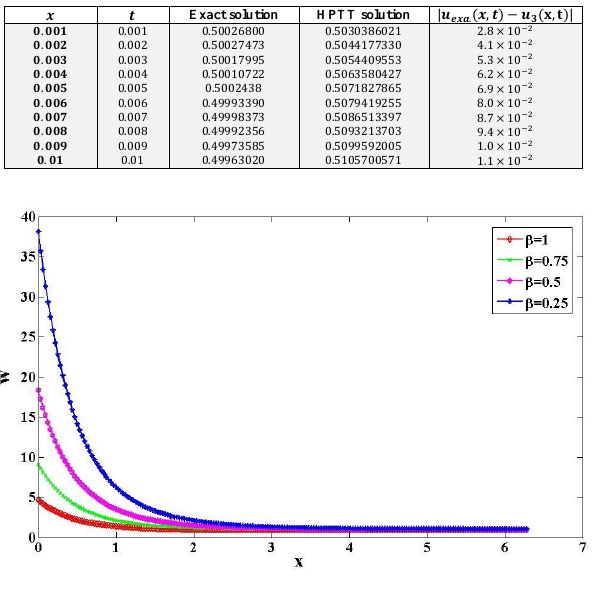
Fig. 4: Plots of w ( x , t ) w.r.t x for varying β , for Ex. 5.2